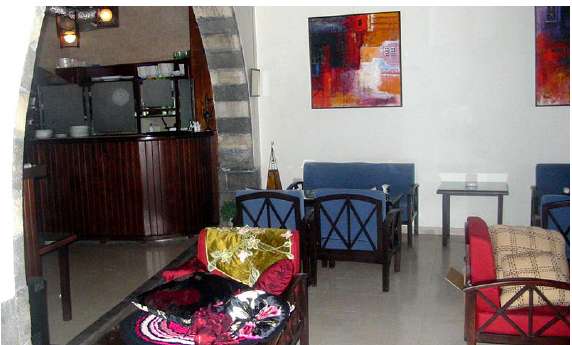
Figure 12. Event “Seasons of Tell al Hejara”, Brochure,